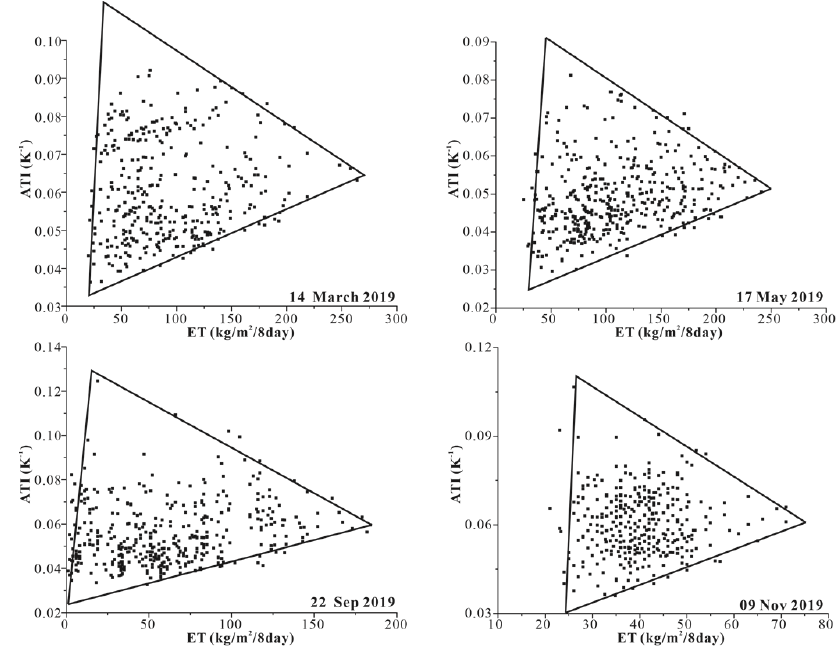
Figure 2. ATI-ET triangular feature space.